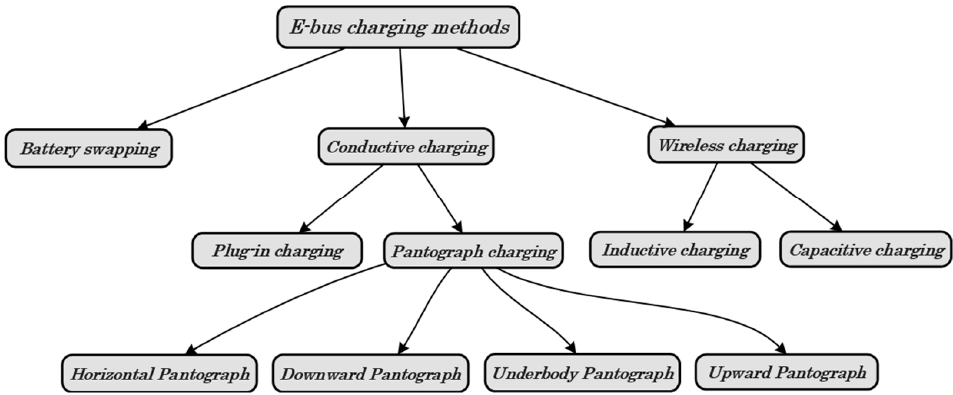
Figure 2. E-bus charging methods.